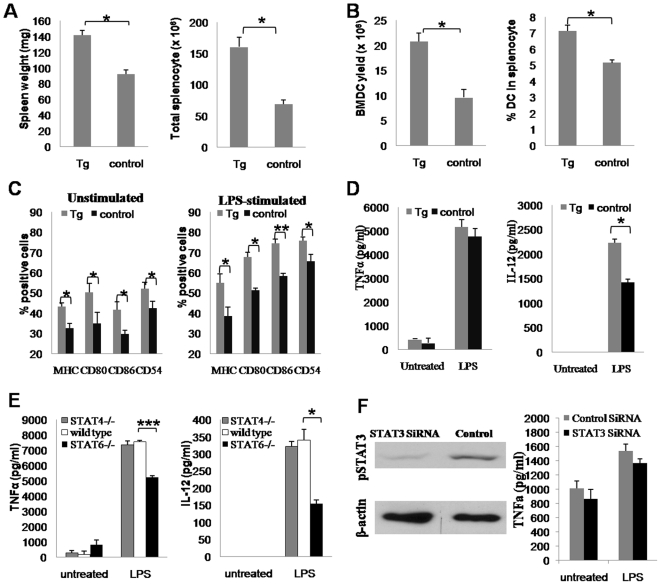
Jak2/STAT5 signaling is indispensable for DC development and maturation, while the capacity of DC for secretion of proinflammatory cytokines is regulated by both Jak2/STAT5 and Jak2/STAT6 signaling.(A) Stat5-Tg mice show larger size for the spleen and higher number of splenocytes. (B) Transgenic Stat5 expression enhances BMDC yield and increases the percentage of splenic DCs in total splenocytes (C) DCs with transgenic Stat5 expression show higher potency in response to LPS stimulation. Significant higher percentage of DCs show matured phenotype as characterized by high levels of MHC II and costimulatory molecule expressions before/after LPS stimulation. (D) ELISA analysis of cytokines secreted by DCs with transgenic Stat5 expression. Stat5-Tg BMDCs showed similar capacity for secretion of TNFα, while the production of IL-12 was significantly higher than that of control BMDCs after LPS stimulation. (E) ELISA analysis of cytokine secretion by BMDCs generated from Stat4−/− and Stat6−/− mice. Stat6−/− BMDCs showed significant lower capacity for secretion of TNFα and IL-12 upon LPS stimulation. In contrast, Stat4−/− BMDCs showed similar capacity for secretion of above indicated cytokines as control BMDCs. (F) Down-regulation of Stat3 in DC2.4 cell by siRNA. DC2.4 cells were first transfected with a Stat3-specific siRNA or a scramble RNA followed by LPS stimulation for analysis of cytokine secretion. Left panel: Western blot results showing significant down-regulation of pSTAT3 in cells transfected with siRNA. Right panel: ELISA analysis of cytokine secretion. IL-12 was undetectable in both siRNA and scramble transfected DC2.4 cells, while siRNA transfected DC2.4 cells showed similar capacity for secretion of TNFα. Data shown in the figure are presented as mean ± SE. *, p<0.05; **, p<0.01; ***, p<0.001.